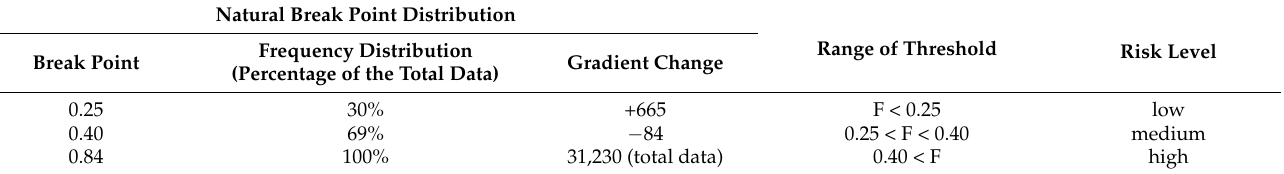
Table 5. Threshold value natural break point classification.